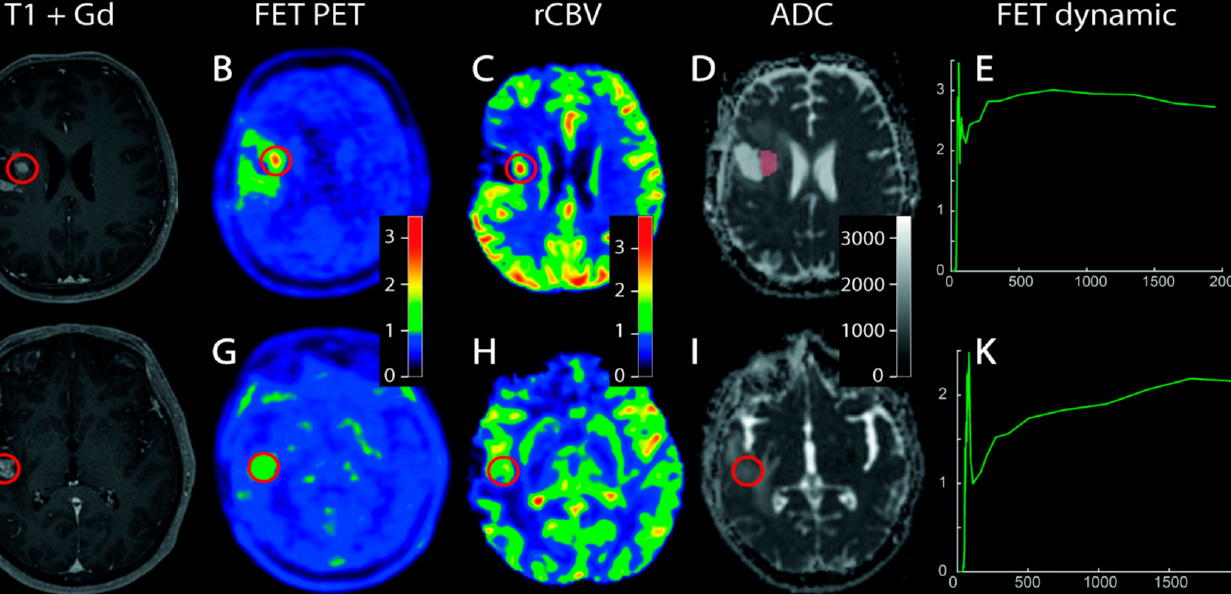
Table 4. Summary of studies investigating the diagnostic accuracy of [ 11 C]CHO PET .